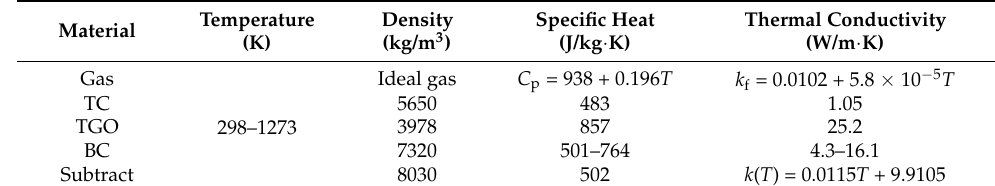
Table 3. Material properties.